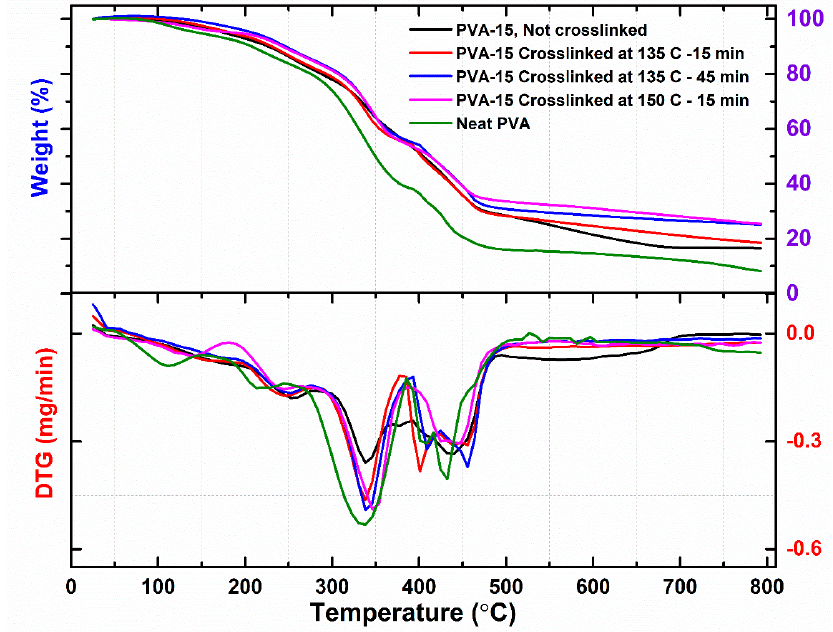
Figure 4. Thermogravimetric analysis (TGA) ( top ) and DTG ( bottom ) thermograms for various